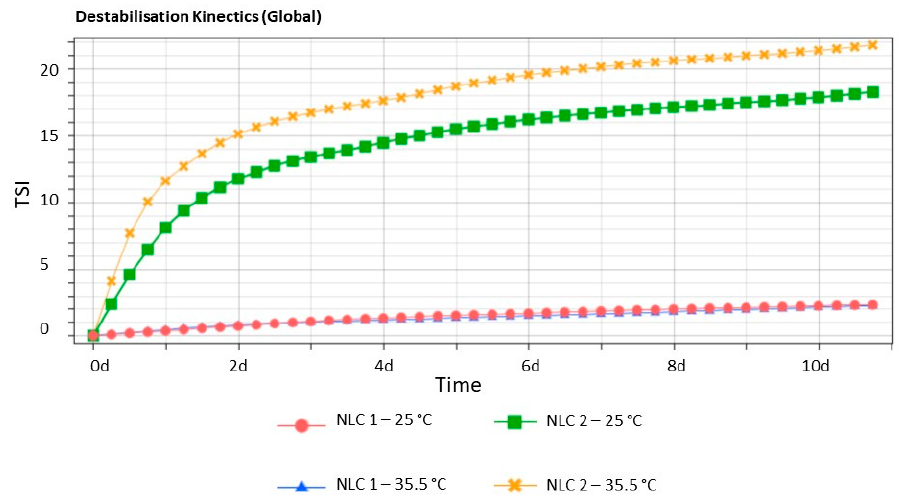
Figure 1. Destabilization kinetics represented in terms of evolution of Turbiscan ® Stability Index (TSI) of NLC 1 and NLC 2 stored 14 days at 25 and 35.5 ◦